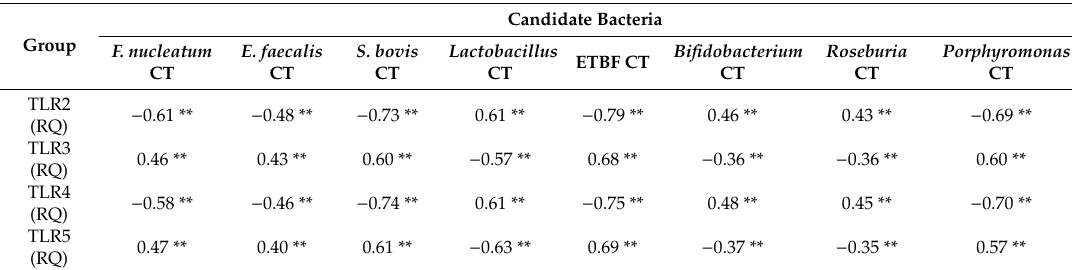
Table 4. Association between candidate bacteria and the relative expression of TLR2, TLR3, TLR4, and